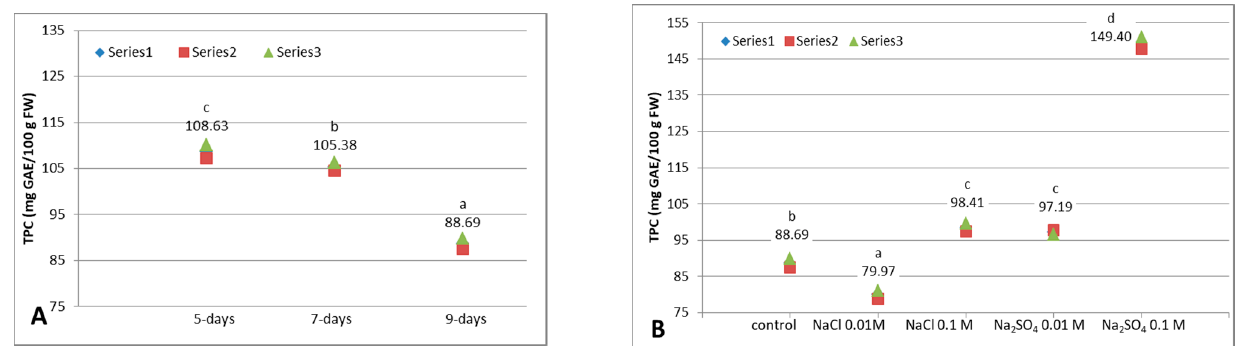
Figure 1. Total phenolic content (TPC, mg GAE/100 g FW) of white cabbage microgreens. ( A ). Influence of growth: untreated 5-, 7- and 9-day-old microgreens ( α = 0.05, between groups df = 2, F = 247.962, p = 0.000). ( B ). Influence of NaCl or Na 2 SO 4 treatments on 9-day-old microgreens ( α = 0.05, between groups df = 4, F = 1657.826, p = 0.000). Above the data points are displayed the mean values and a letter: different letters denote significant differences between values (Tukey HSD test). Series 1, 2 or 3 from the legend represent the 3 individual experiments.